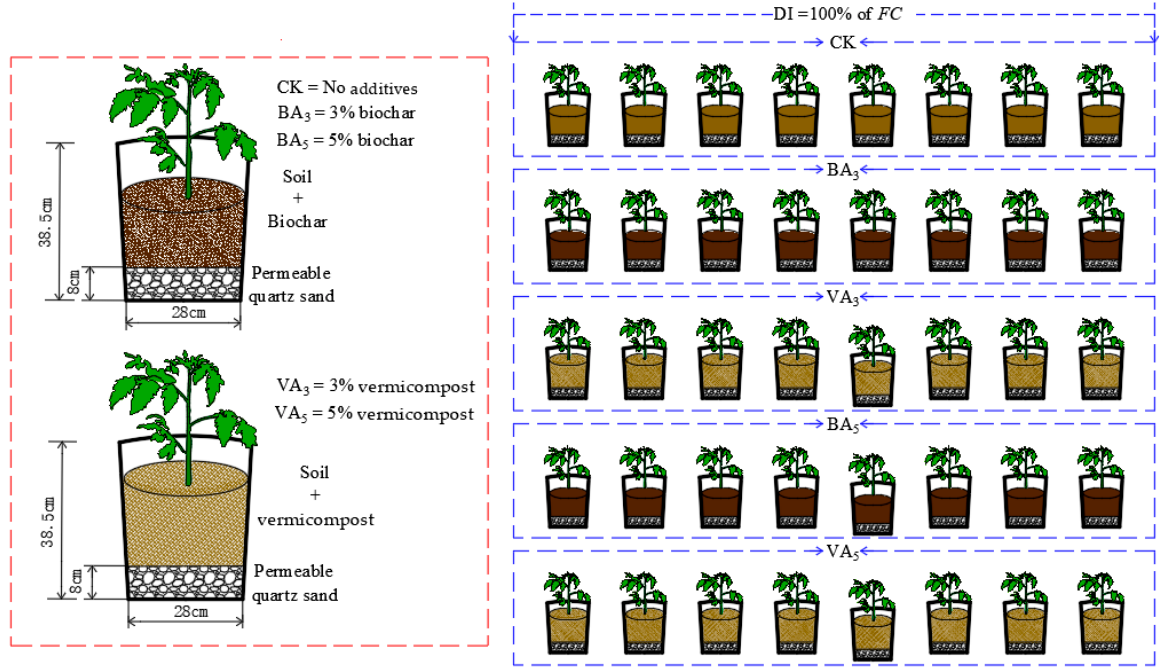
Figure 1. Layout of tomato pots in the greenhouse.